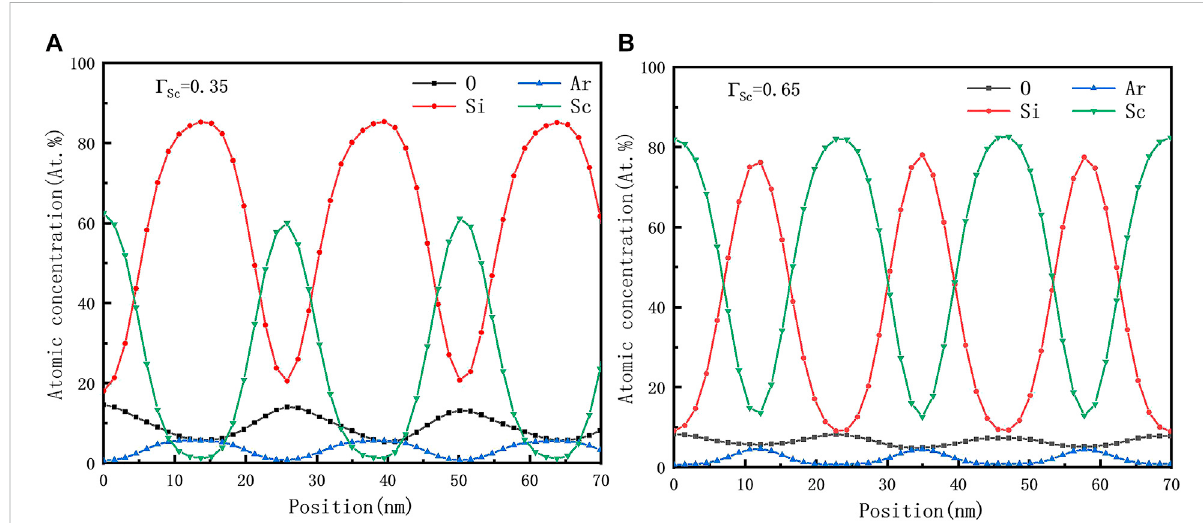
Depth distribution of the chemical elements of Sc/Si multilayers with Γ Sc = 0.35 (A) and Γ Sc = 0.65 (B) . Sc/Si re fl ectivity measurement by synchrotron radiation.